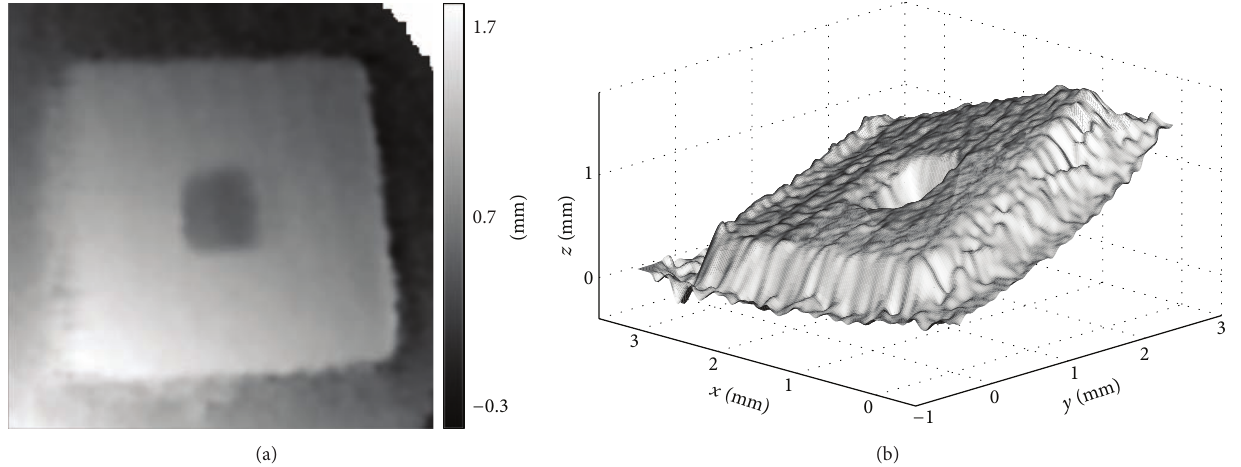
Figure 11: Closed-space experiment. (a) Surface height map in 2D and (b) surface profile in 3D of the MEMS